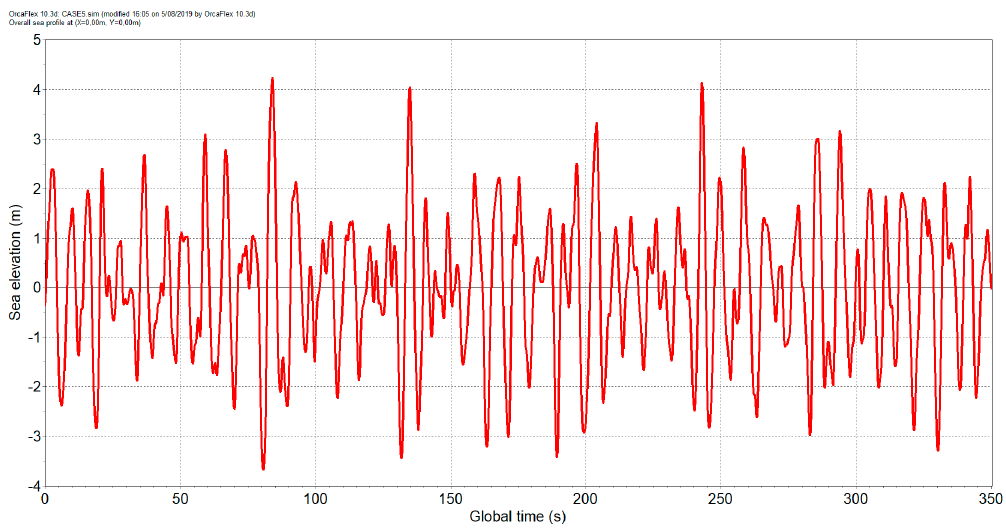
Figure 11. Time series of free surface elevation at origin (0, 0).